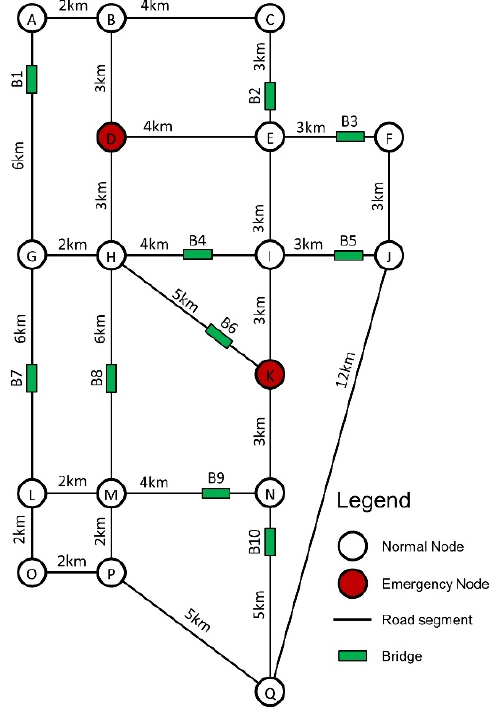
Figure 2. Hypothetical transportation network. Table 2. Fragility parameters for Table 2. Fragility parameters for bridges.